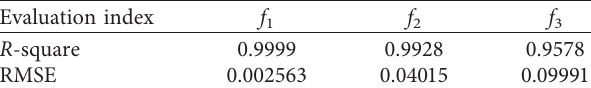
Figure 5: Piecewise cubic spline interpolation function model of average pupil diameter. (a) Piecewise cubic spline interpolation function. (b) Function f 1 fitting. (c) Function f 2 fitting. (d) Function f 3 fitting. Table 5: Evaluation index of the driver’s average pupil diameter fitting model in tunnel